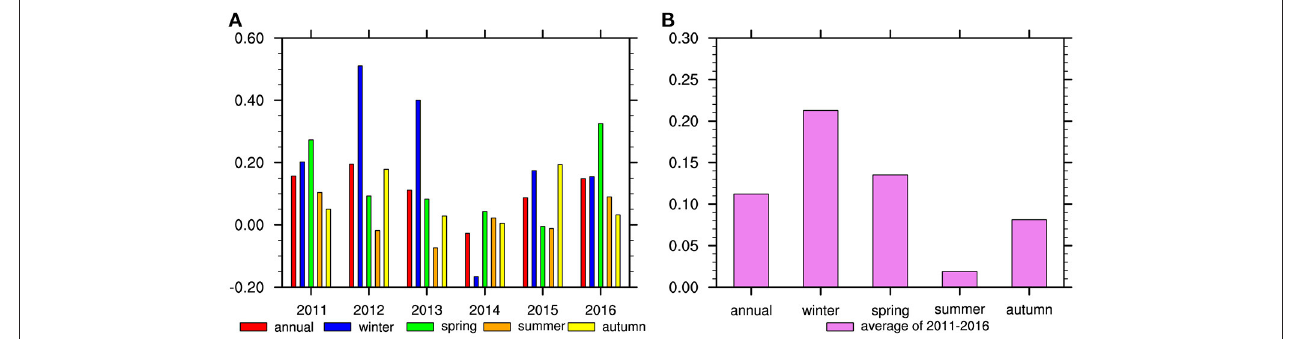
FIGURE 1 | The prediction skill of (A) annual average (red bar), winter (blue bar), spring (green bar), summer (orange bar), and autumn (yellow bar) for each year of 2011–2016. (B) 2011–2016 averaged skills for annual mean and four